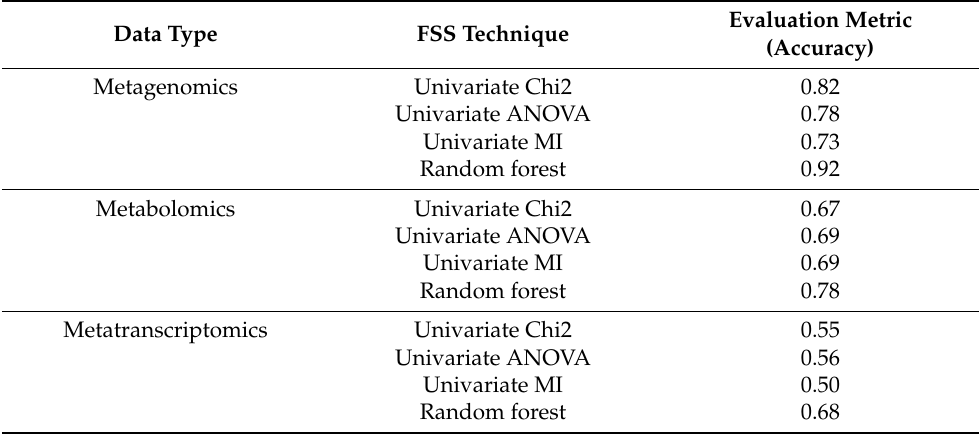
Table 4. Classification accuracy of univariate feature subset selection techniques. Results shown for univariate feature selection correspond to k = 200 best features. Feature importance using RF is also reported. Data